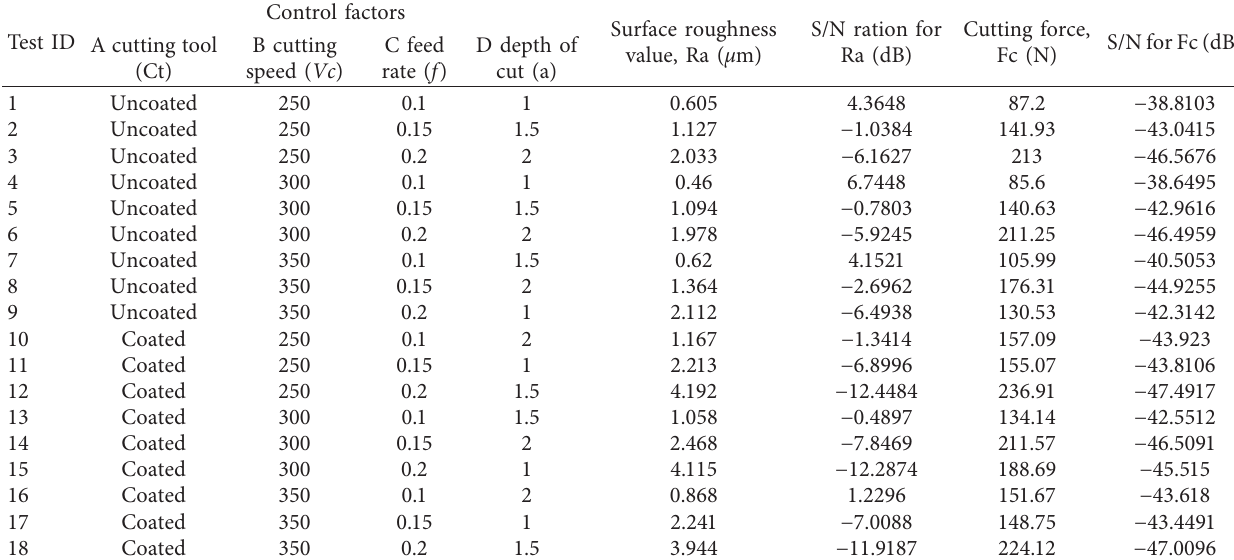
Table 4: Results of experiments and S/N ratio values.